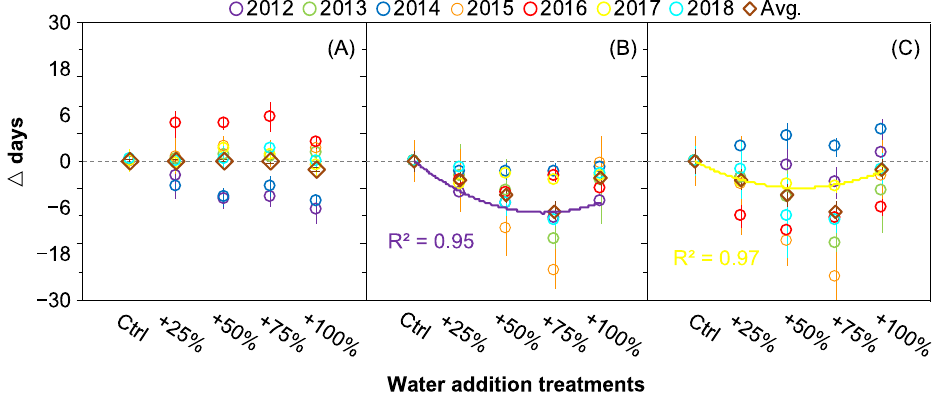
Figure 3. Correlations between the seed release onset ( A ), end ( B ), and duration ( C ) and the water addition treatments in Nitraria tangutorum . The solid lines indicate p ≤ 0.05.